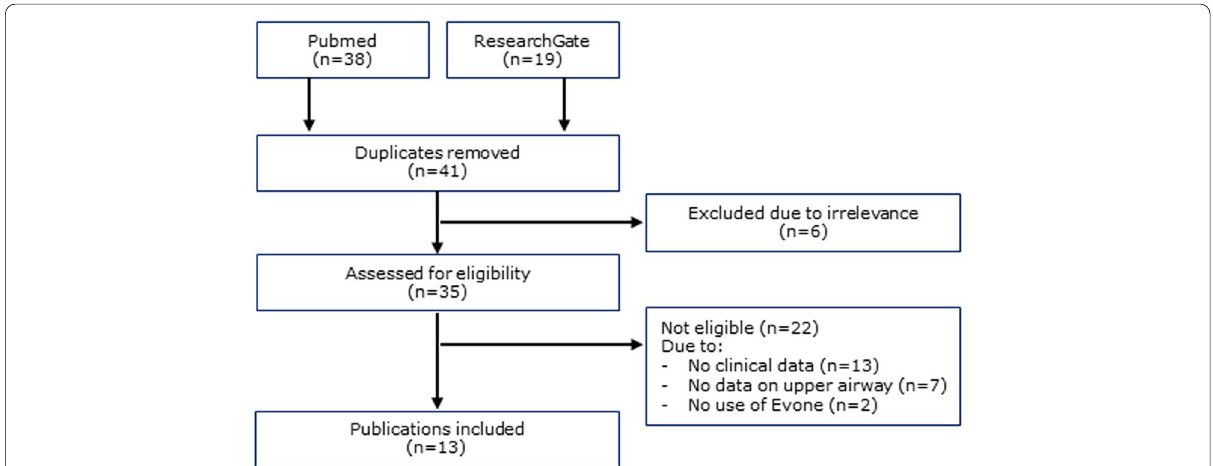
Fig. 5 PRISMA flow diagram indicating the citation selection process for the systematic